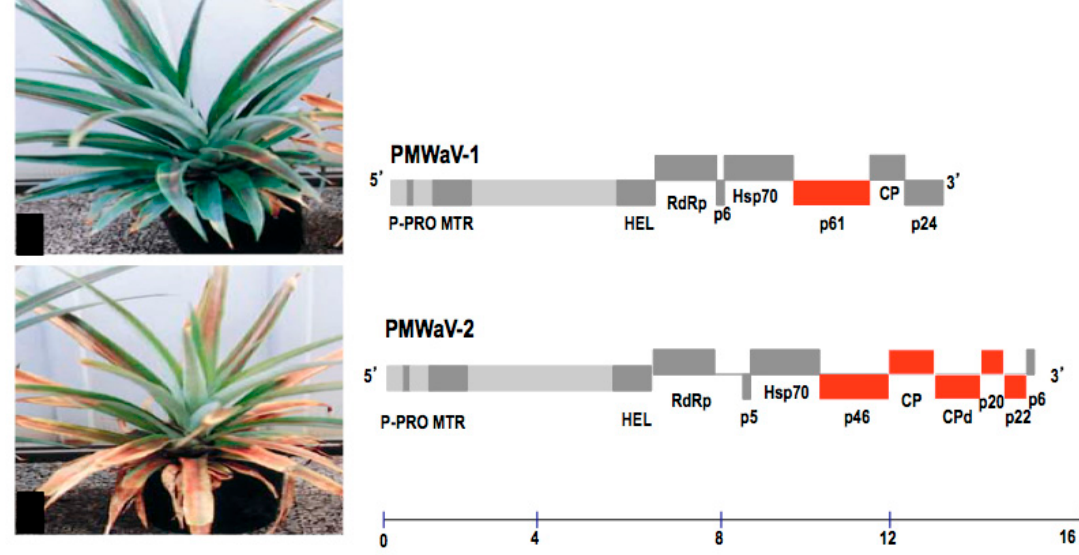
Figure 7. Top: a symptomless pineapple plant infected by PMWaV-1, and its associated genome organization. Below: a symptomatic pineapple plant infected by PMWaV-2, exhibiting typical wilting symptoms and its genome organizations. In the genome organization, boxes represent open reading frames (ORFs), while homologous genes or domains are shown with the same pattern for both viruses. Red boxes represent ORFs that were identified asRNA silencing uppressors.